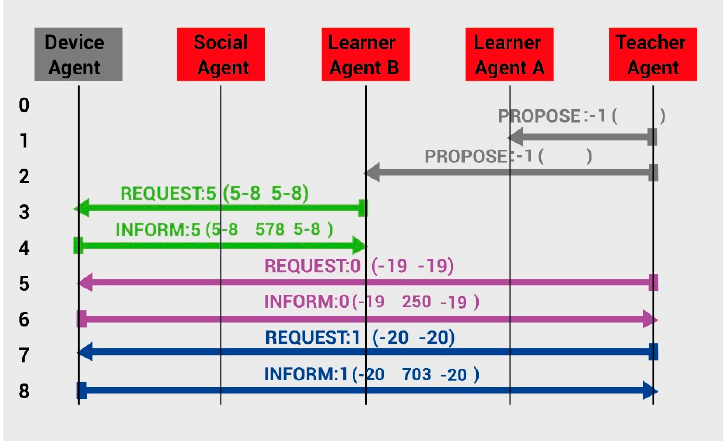
Figure 19. Simulation of interactions between agents.